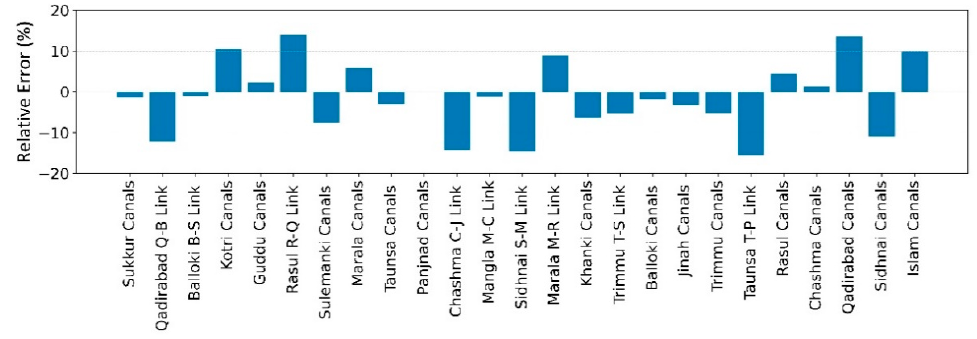
Figure 9. Mean annual modelled relative volumetric error (%) for 2002–2012 at canals and offtakes.